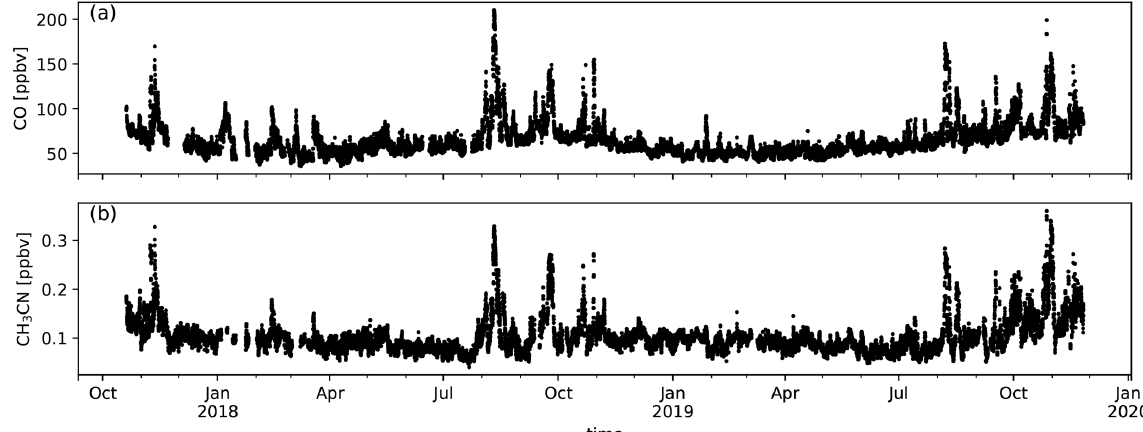
Figure A1. Measured CO (a) and CH 3 CN (b) mixing ratios (ppbv) during the deployment of the hs-PTR-MS for the OCTAVE